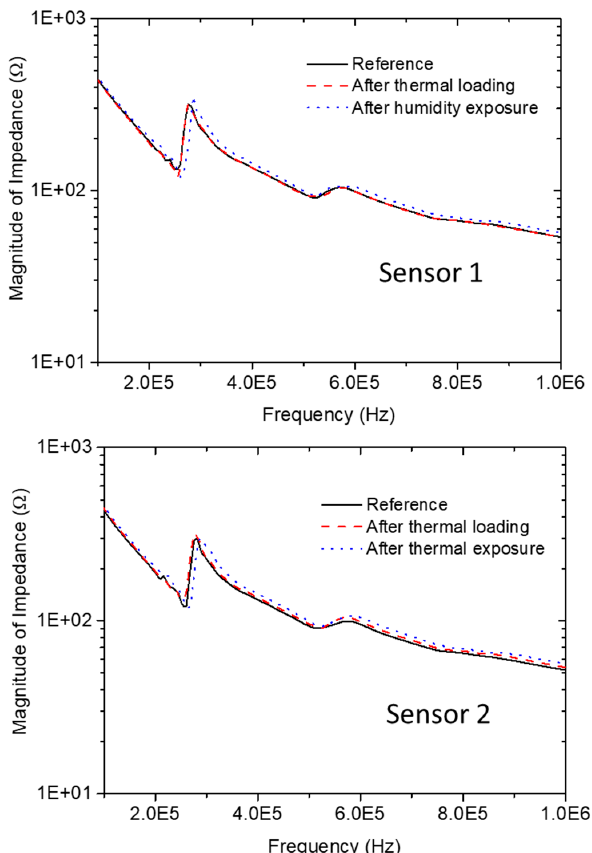
Figure 11. Evolution of imaginary impedance spectrum of both piezoelectric lead zirconate titanate (PZT) sensors before and after thermal loading and humidity exposure.